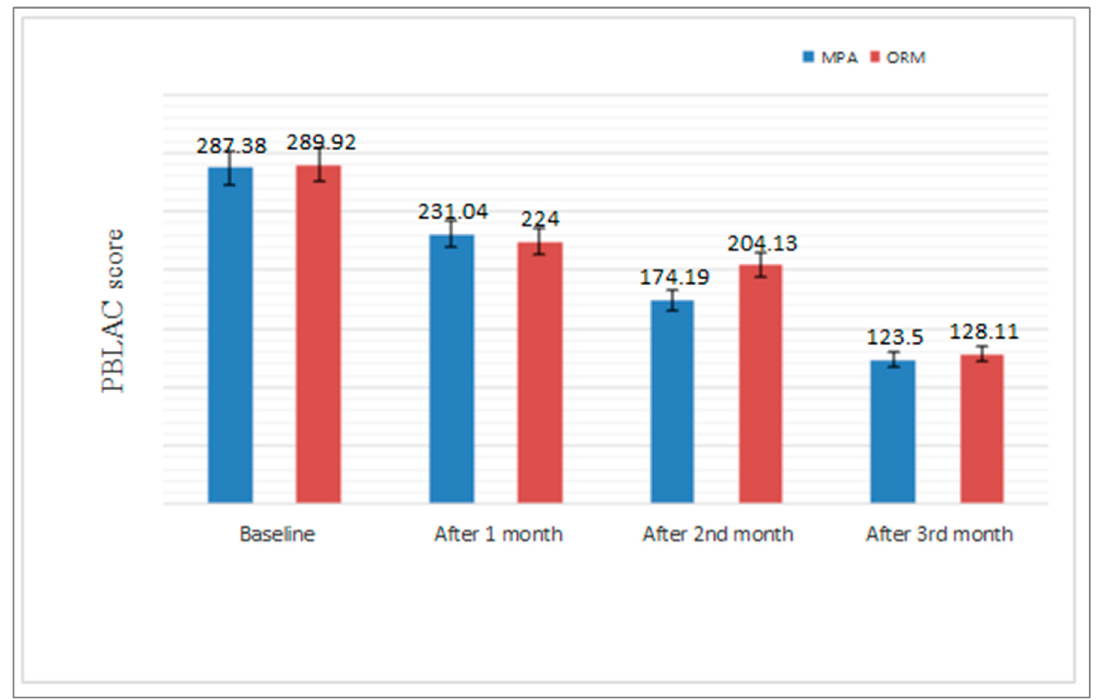
represent significance.